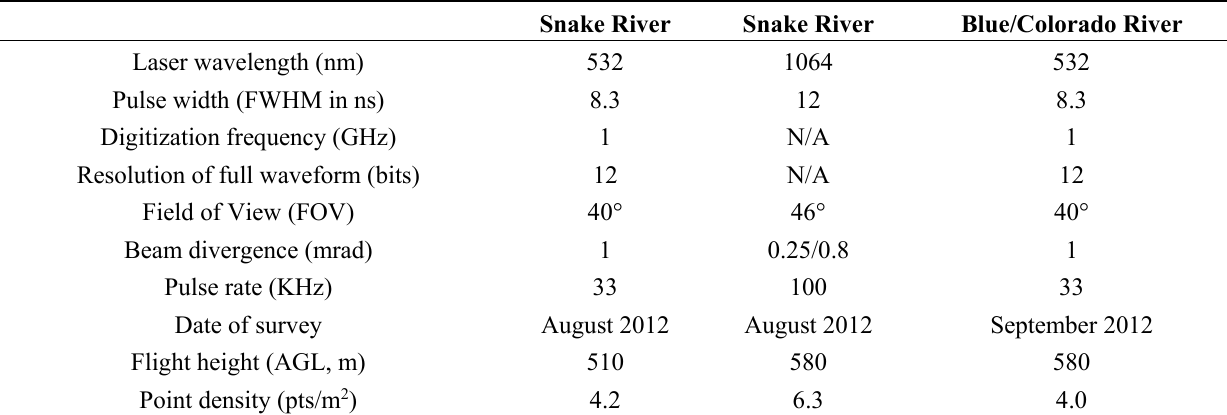
Table 1. Airborne LiDAR acquisition